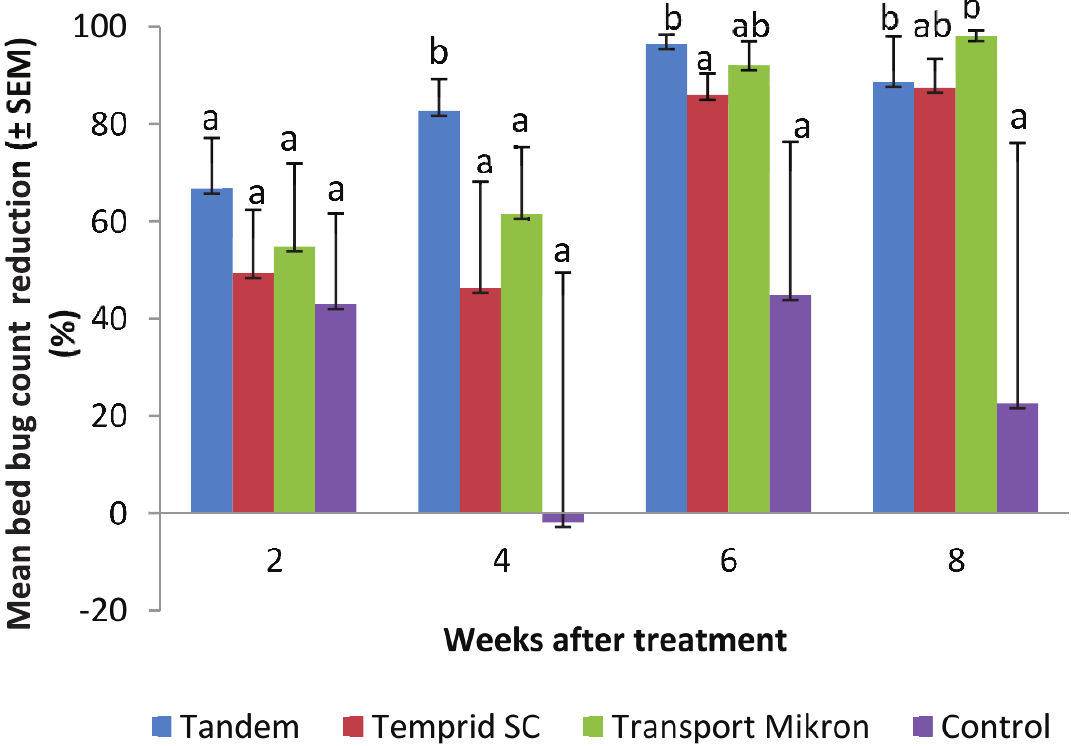
Figure 2. Effect of the treatments on bed bug population reduction. Bars of the same period followed by different letters indicate significant differences ( P <